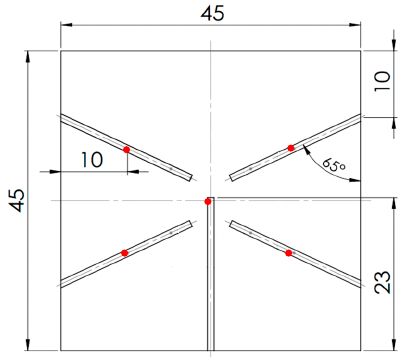
Figure 3. The location of the temperature measurement points on the heat sink base.